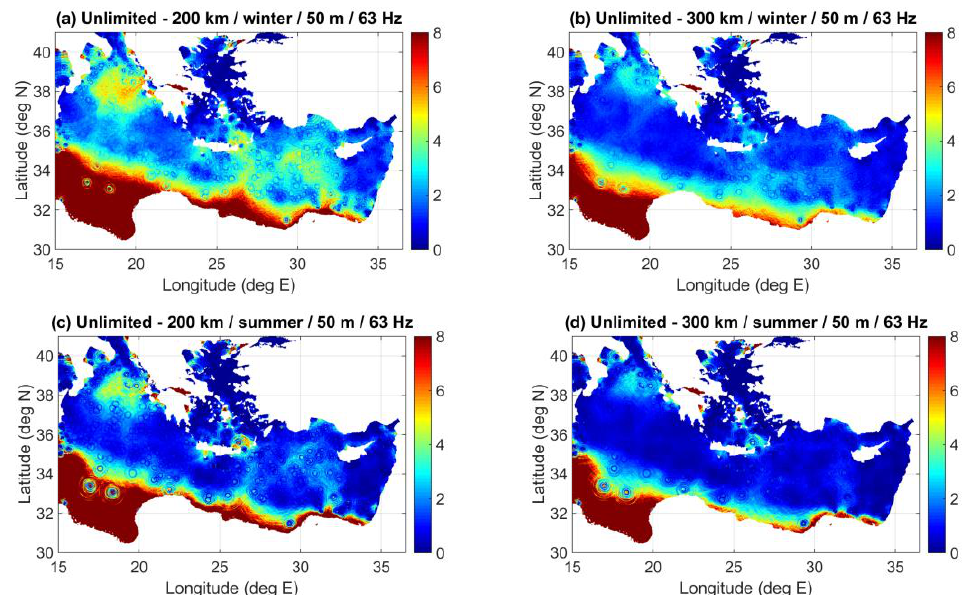
Figure 15. Differences between noise distributions (dB re 1 μPa 2 /Hz) predicted from coupled-mode calculation without and with range limitation at a depth of 50 m, at a frequency of 63 Hz from the noise source distribution of Figure 10 in the Eastern Mediterranean Sea, assuming source depth of 5 m and spectral source level of 165 dB re 1 μPa 2 /Hz @ 1 m. Difference between predictions in winter for range limitation of ( a ) 200 km and ( b ) 300 km. Difference between predictions in summer for range limitation of ( c ) 200 km and ( d ) 300 km. Differences reach 20 dB (in the dark red areas) but they are cropped over 8 dB.